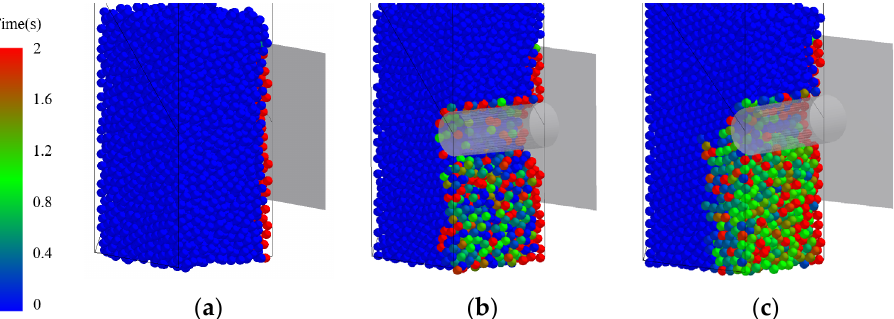
Figure 5. Particle contact time distributions of particle flow around different surface under different situation at t = 41 s: ( a ) Case 1; ( b ) Case 2; and ( c ) Case 4.